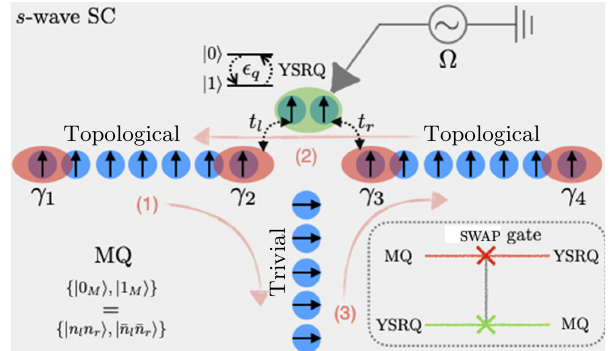
FIG. 5. A sketch of the hybrid YSR qubit (YSRQ) – Majorana qubit (MQ). The magnetic adatoms (black arrows) deposited on the top of an s -wave SC form three Shiba chains in a T -junction geometry. The left ( l ) and right ( r ) chains are assumed to be topological, hosting Majorana zero modes γ i ( i = 1, . . . , 4) at their ends (red), and are coupled via tunnelings t l , r to a spin dimer that accommodates a YSRQ (green), while the lower Shiba chain is nontopological. The states of the MQ are defined by the fermionic occupations n l ( r ) = 0, 1 of the two Majorana modes on the left (right) chain and the topologically protected Clifford gates can be implemented by braiding [steps (1), (2), and (3)] and fusing the Majorana zero modes. Driving the dimer locally rotates the YSRQ coherently (see Sec. IV) and by combining this rotation with the SWAP gates facilitated by t l , r (described in detail in Ref. [99]), the missing π/ 8 phase gate can be implemented. The SWAP gate can also be used for the measurement of the MQ via the readout of the